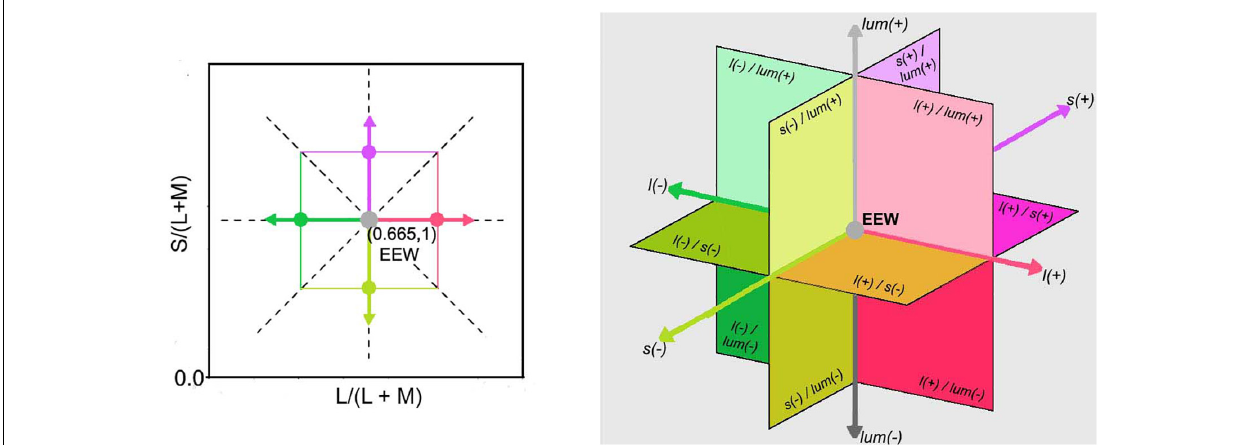
FIGURE 2 | (Left) Representation of the McLeod & Boynton cone chromaticity space showing cardinal and non-cardinal axes on the equiluminant l-s plane with the L/(L + M) axis set as reference, instead of M/(L + M). The two dashed line diagonals in the graph represent two non-cardinal axes, one with positive slope (same polarity) and the other with negative slope (opposite polarity). The angles of them with respect to the horizontal or vertical cardinals are illustrative and do not necessarily match the angles used in this experiment. (Right) A three-dimensional Cartesian representation with a luminance axis perpendicular to an equiluminant plane and origin in EEW is shown. The directions of increments [l(+), s(+), and lum(+)] and decrements [l(–), s(–), and lum(–)] for each cardinal axis are specified as well as the regions where combinations of two channels are stimulated.